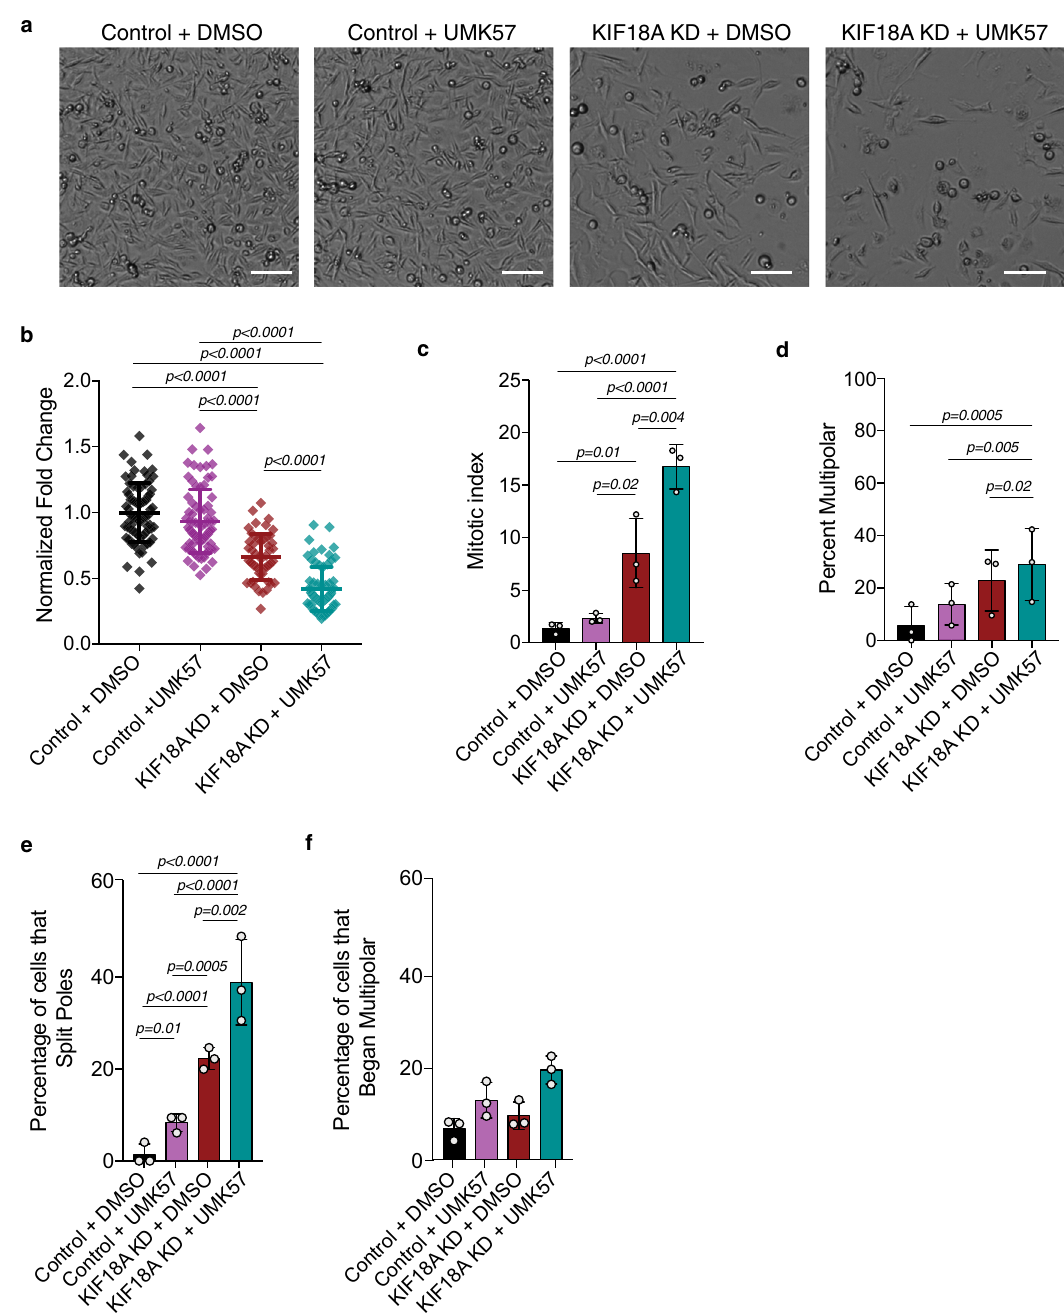
Fig. 8 KIF18A KD-induced defects depend on dynamic microtubules and are enhanced by increased KIF2C/MCAK activity. a Representative images (from three independent experiments) of MDA-MB-231 cell density 96 h after the start of high-contrast bright- fi eld imaging. Cells were treated with either control or KIF18A siRNAs in combination with DMSO or 500 nM UMK57. Scale bar is 100 microns. b Fold change in cell density after 96 h in MDA-MB- 231 cells treated with the speci fi ed siRNAs and either 500 nM UMK57 or DMSO. n = 76 (control KD + DMSO), 52 (control KD + UMK57), 76 (KIF18A KD + DMSO), and 68 (KIF18A KD + UMK57) wells of cells from three independent experiments. Data were analyzed via one-way ANOVA with post hoc Tukey ’ s test for multiple comparisons. c , d Percent of total mitotic cells ( c ) and mitotic cells with multipolar spindles ( d ) in fi xed populations after the indicated treatments. n = 3 independent experimental replicates per condition. Data were analyzed via one-way ANOVA with post hoc Tukey ’ s test for multiple comparisons. e , f Percent of live, siR-tubulin-labeled MDA-MB-231 cells that ( e ) split poles or ( f ) entered mitosis with more than two spindle poles after the indicated treatments. n = 126 (control KD + DMSO), 158 (control KD + UMK57), 172 (KIF18A KD + DMSO), and 152 (KIF18A KD + UMK57) mitotic cells from three independent experiments. Data were analyzed via a two-sided Chi-square test. All graphs show mean ± SD and individual data points. P values <0.05 are